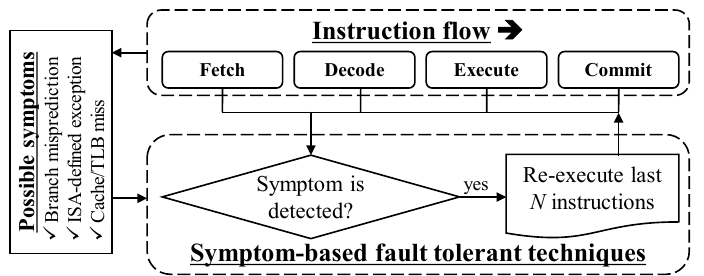
Figure 1. Diagram of symptom-based fault tolerant